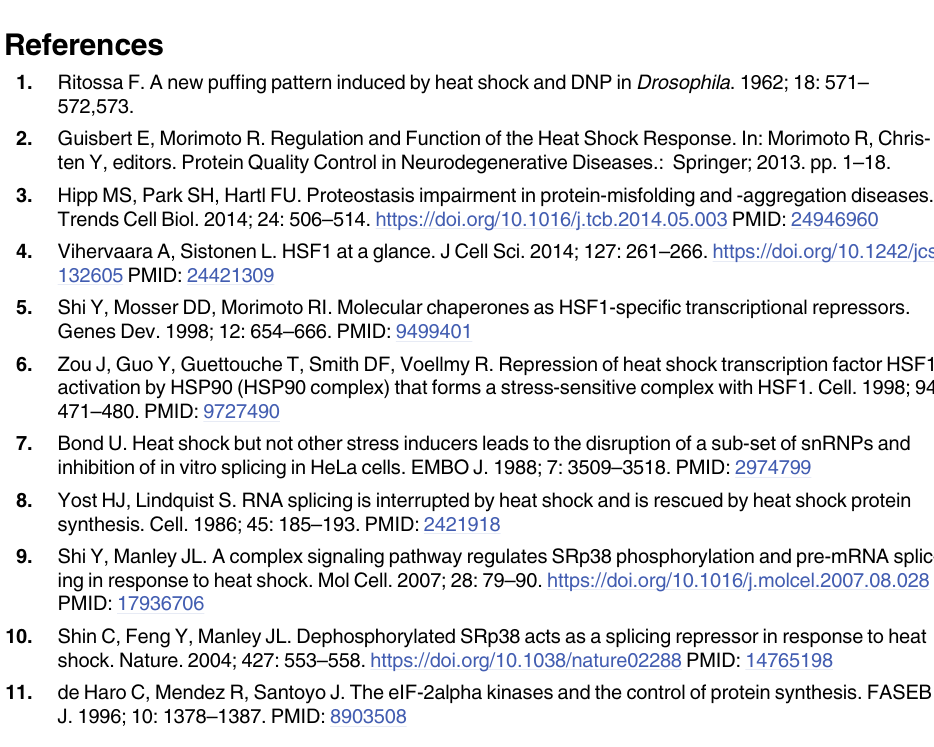
S1 Table. Data supporting each figure displayed in the manuscript.